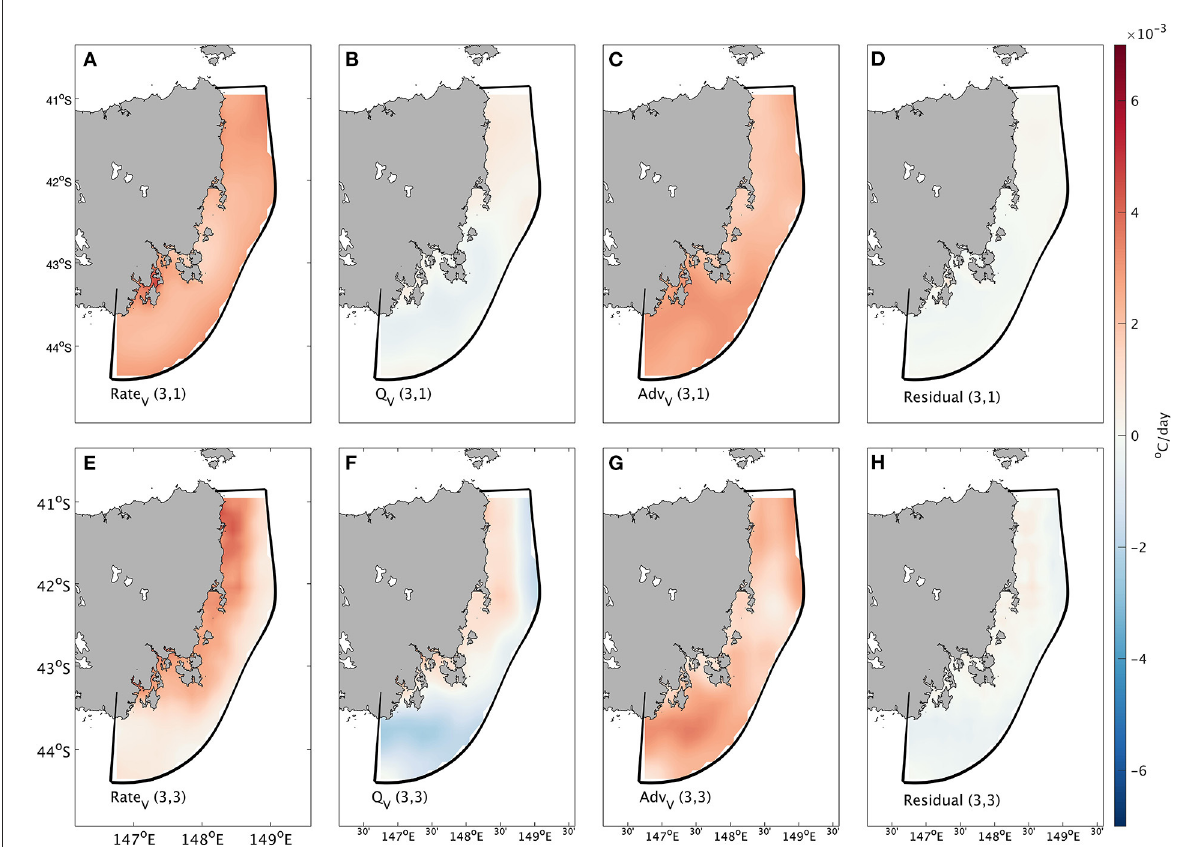
FIGURE7 Outputs from the heat budget analysis. Averaged total change rate anomaly ( ◦ C/day) in (A) Node (3, 1) and (E) Node (3, 3). Averaged change rate anomaly ( ◦ C/day) due to surface heat flux in (B) Node (3, 1) and (F) Node (3, 3). Averaged change rate anomaly ( ◦ C/day) due to advection in (C) Node (3, 1) and (G) Node (3, 3). Averaged change rate anomaly ( ◦ C/day) due to residuals in (D) Node (3, 1) and (H) Node (3,